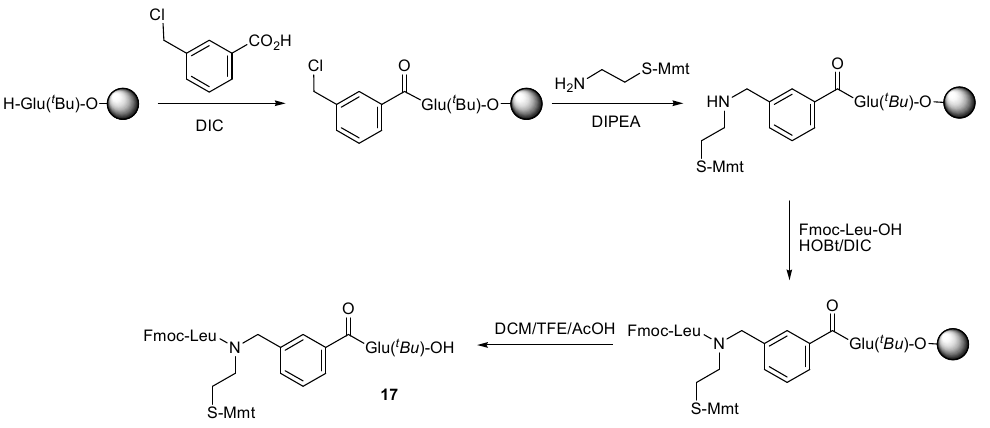
Scheme 3 . Synthesis of peptide–peptoid hybrid 17 using m -chlorobenzoic acid. Table 1. Retention time (t R ), yield of the crude product (%), HPLC purity of the crude products (%), m/z (calculated and found) of the peptide–peptoid hybrids 9 – 17 .